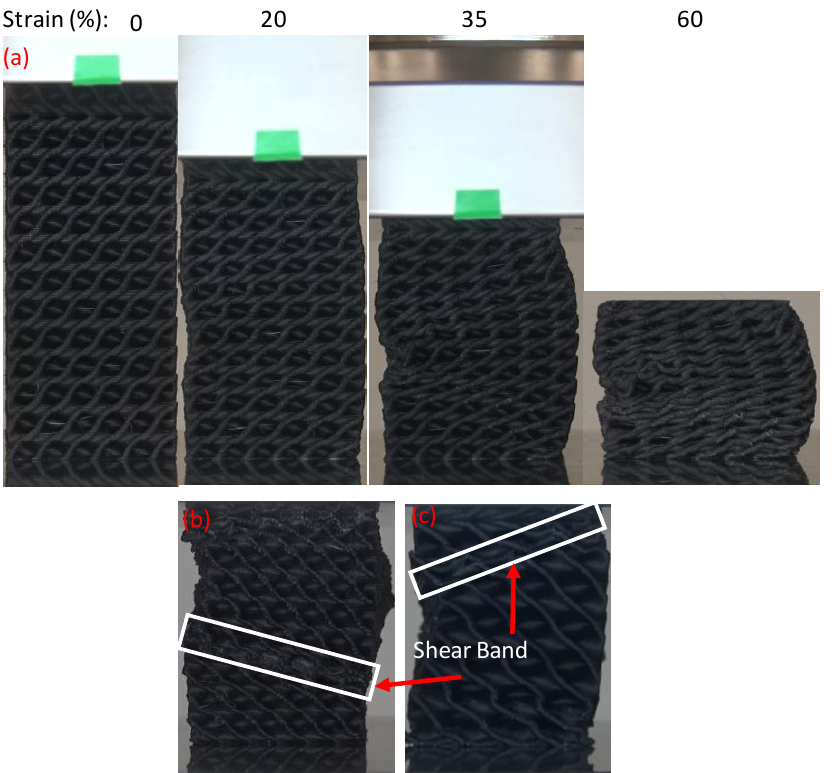
Figure 15. Deformation features of typical Diamond structures: ( a ) D-8-44, ( b ) shear band deformation of D-8-23 (at 35% strain), and ( c ) shear band deformation of D-12-30 (at 35% strain).